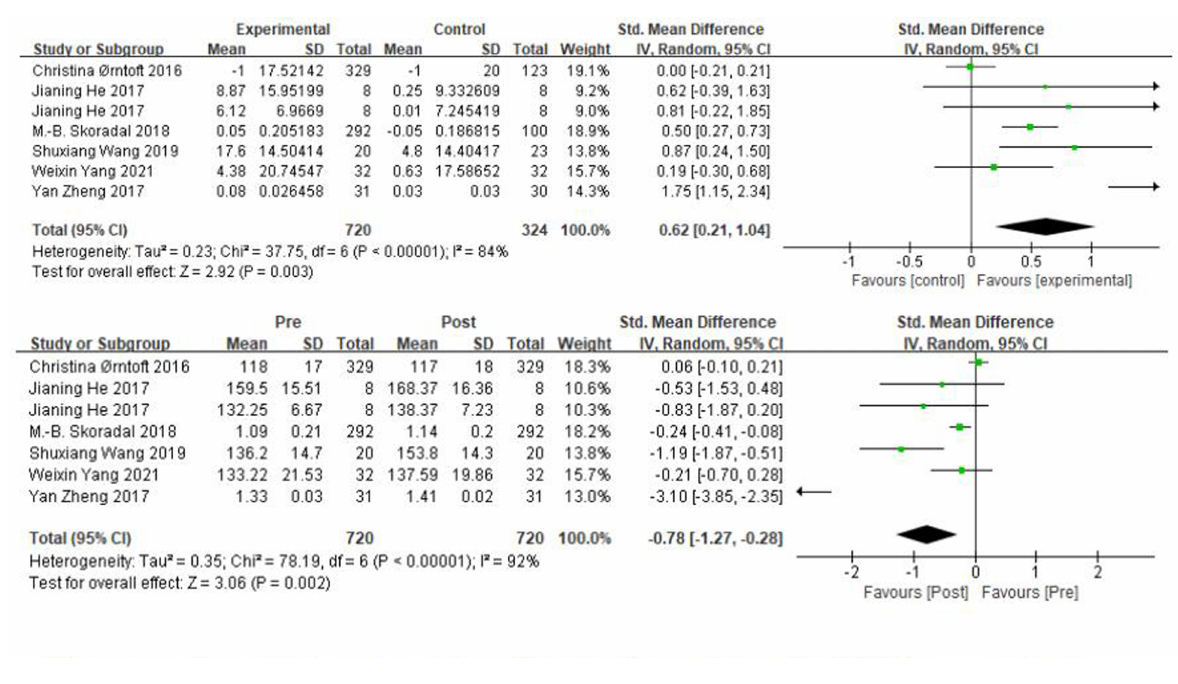
FIGURE 5 A meta-analysis of the results of horizontal jump was conducted for comparisons between the control and experimental groups and for comparisons between the experimental groups pre- and post-intervention.